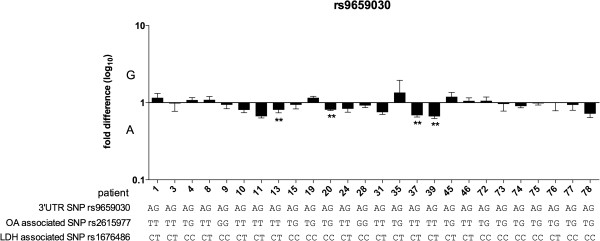
Allelic expression analysis in cartilage samples from OA patients assessed using the 3′UTR SNP rs9659030. The genotypes of the patients at rs9659030, at the OA associated SNP rs2615977 and at the LDH associated SNP rs1676486 are shown. P-values were calculated by comparing the cDNA allelic ratio to the DNA allelic ratio using a Mann–Whitney U test. ** denotes p < 0.01.